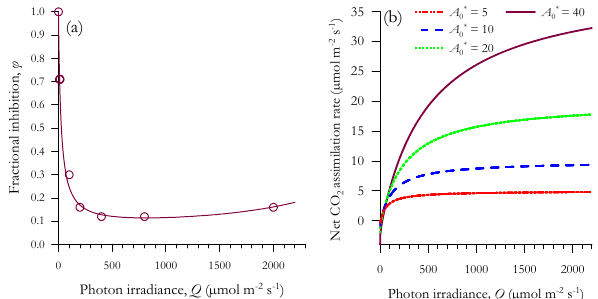
Fig. A1. Key features of the model. (a) Inhibition of leaf respira- tion in the light (Eq. A6); (b) Predicted variations net CO 2 assimi- lation rates for a range of leaf photosynthetic capacities (expressed as a maximum CO 2 assimilation rate in the absence of dark respi- ration, A ∗ , with units of µmolm − 2 s − 1 ) including an allowance for 0 inhibition of leaf respiration in the light according to Eq. (A1) with R z from Eq. (A6) and with φ =0.008molCO 2 mol − 1